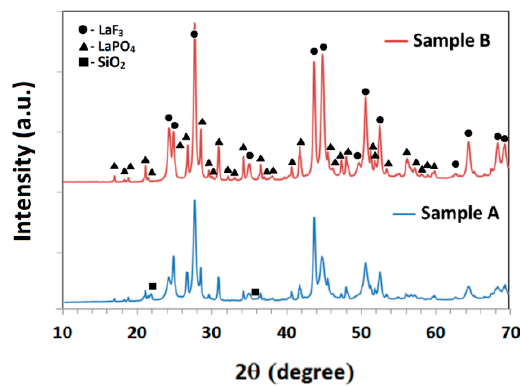
Figure 6. XRD patterns of acid leach residue show mainly the peaks of rare earth (RE) fluorides and phosphates. Sample A is from plate glass polishing and sample B is from mirror polishing.